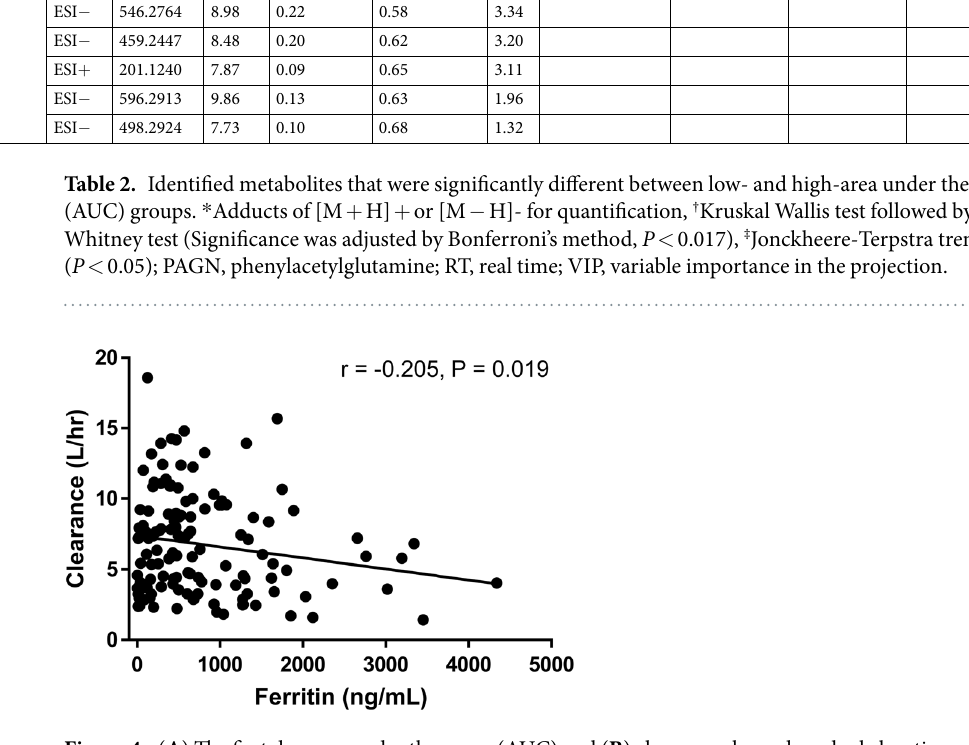
estimated by magnetic resonance imaging (MRI), and serum ferritin is approximately 0.6 to 0.8, implying that ferritin is an acceptable but imperfect surrogate of true iron burden 35 . In recent studies, iron overload itself (as estimated by LIC) is not associated with an increase in mortality even though high ferritin levels are significantly associated with mortality 35, 36 . These results indicate that hyperferritinaemia rather than iron overload is the more important factor for predicting HSCT outcomes. There are many other conditions, such as infection and inflam- mation, that increase serum ferritin levels, and ferritin levels can vary depending on the physical condition. In addition to iron overload, these various conditions should be considered as factors that can influence busulfan PKs. Further studies are needed to clarify this issue. Two previous population PK studies of busulfan in paediatric patients incorporated ferritin levels as a covar- iate. Busulfan PKs were not influenced by ferritin levels in these studies 37, 38 . However, one study examined thal- assemia patients 37 and the other examined patients with non-malignant diseases 38 . These patient populations are different from the population examined in our study in which the majority had a malignant disease and a history